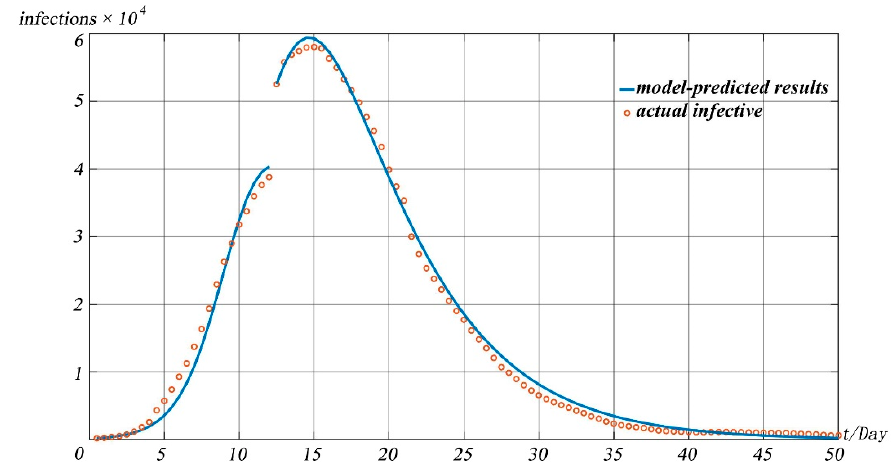
Figure 7. Prediction curve and actual numbers of confirmed COVID-19 cases in China.